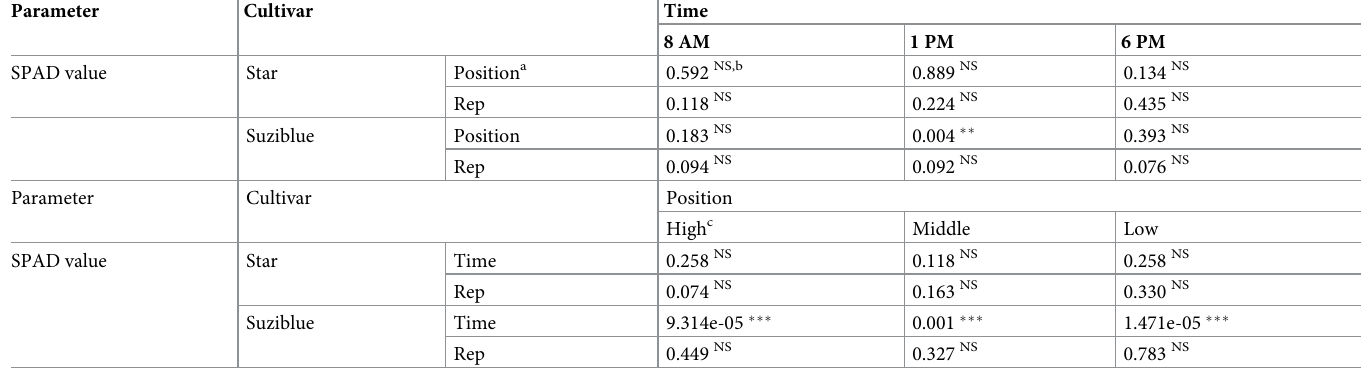
Table 1. P-values from Kruskal-Wallis rank-sum test. ‘Star’ and ‘Suziblue’ were measured at three different times (8 AM, 1 PM, and 6 PM) and three positions (Hight, Middle, and